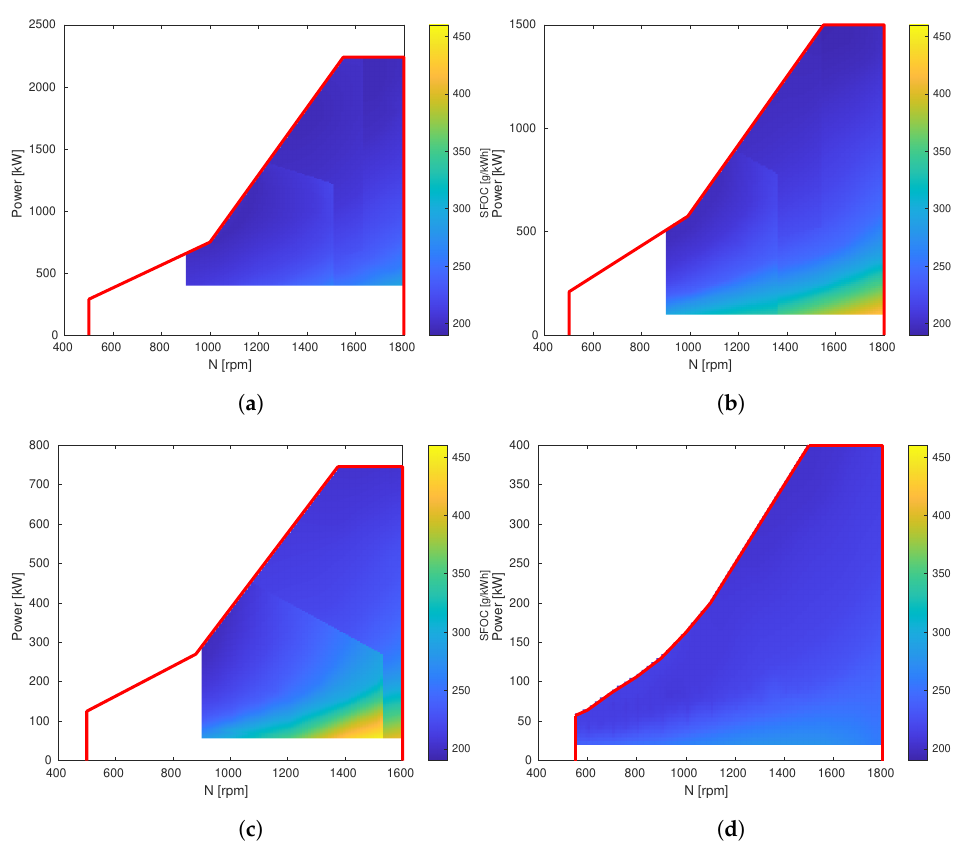
Figure 3. Load diagrams of the engines considered in the study: ( a ) Engine 1; ( b ) Engine 2; ( c ) Engine 3; ( d ) Engine 4.